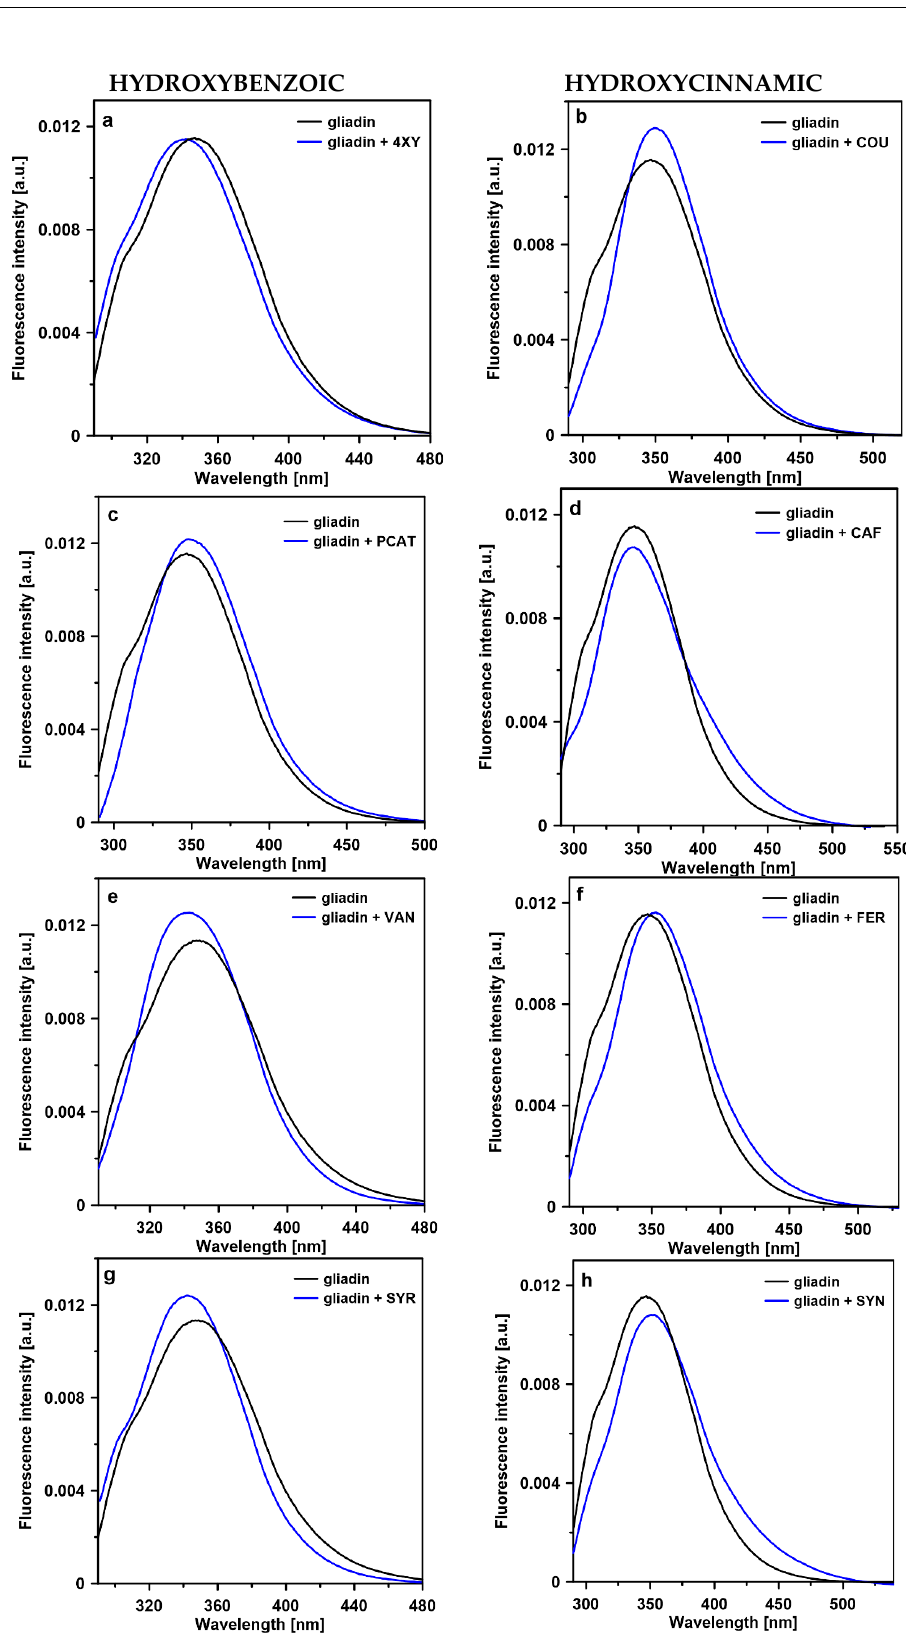
Figure 3. Fluorescence emission spectra recorded from gliadin and complexes of gliadin with phenolic acids: 4-xydroxybenzoic (4XY), coumaric (COU), protocatechuic (PCAT), caffeic (CAF), vanillic (VAN), ferulic (FER), syringic (SYR), and sinapic (SYN) ( a – h ). The excitation wavelength was set at 280 nm. The spectra were normalized to get the same area beneath each